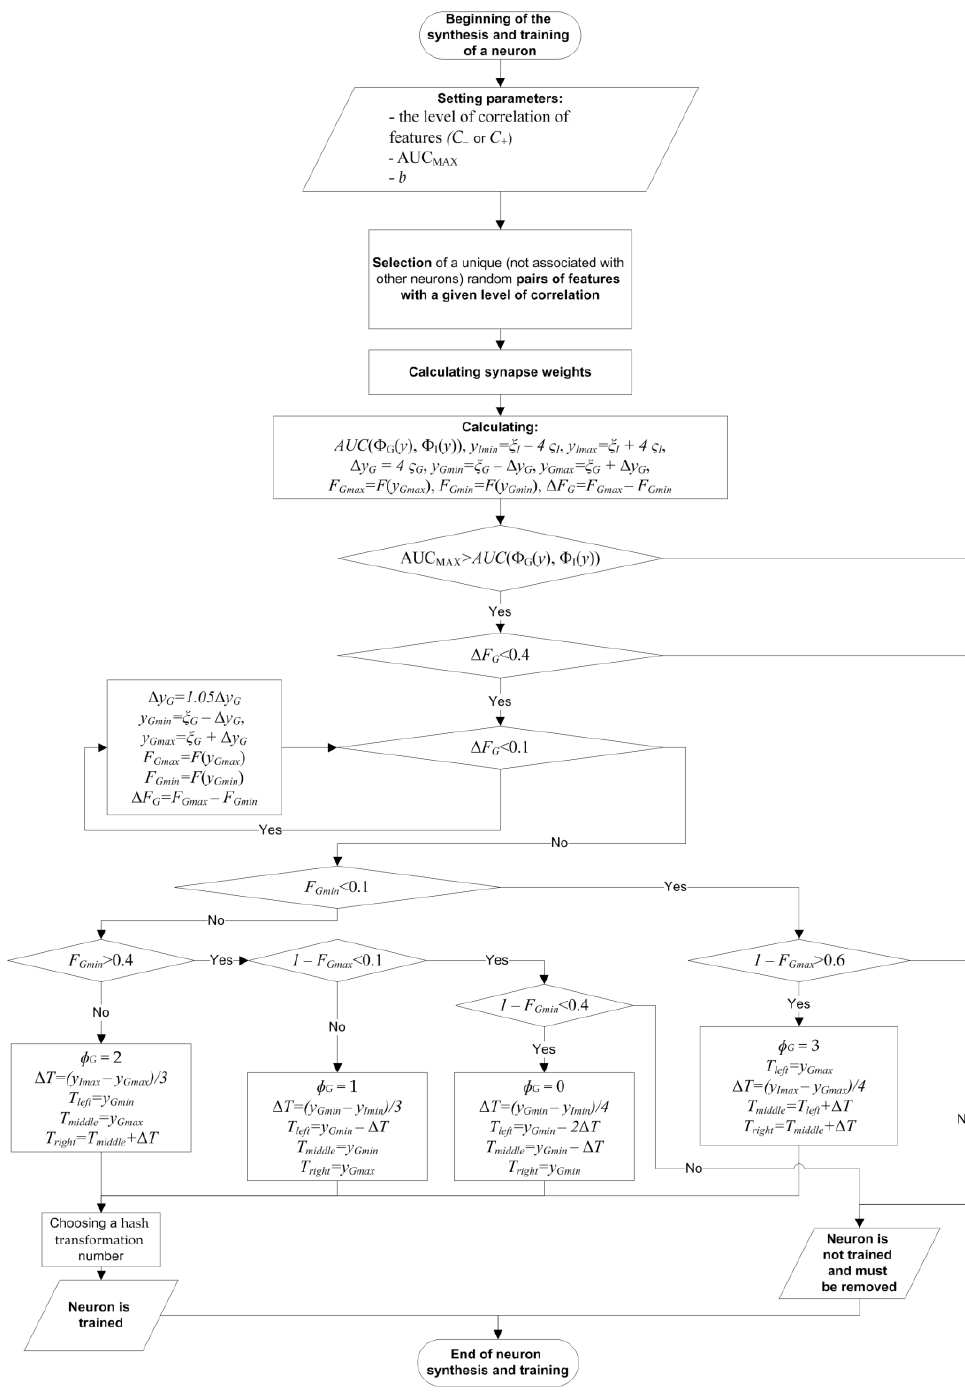
Figure 10. Scheme of the algorithm of synthesis and training of the correlation neuron. Table 1. Variants of the hashing transformations of the neuron response ɸ (y) into a binary code.